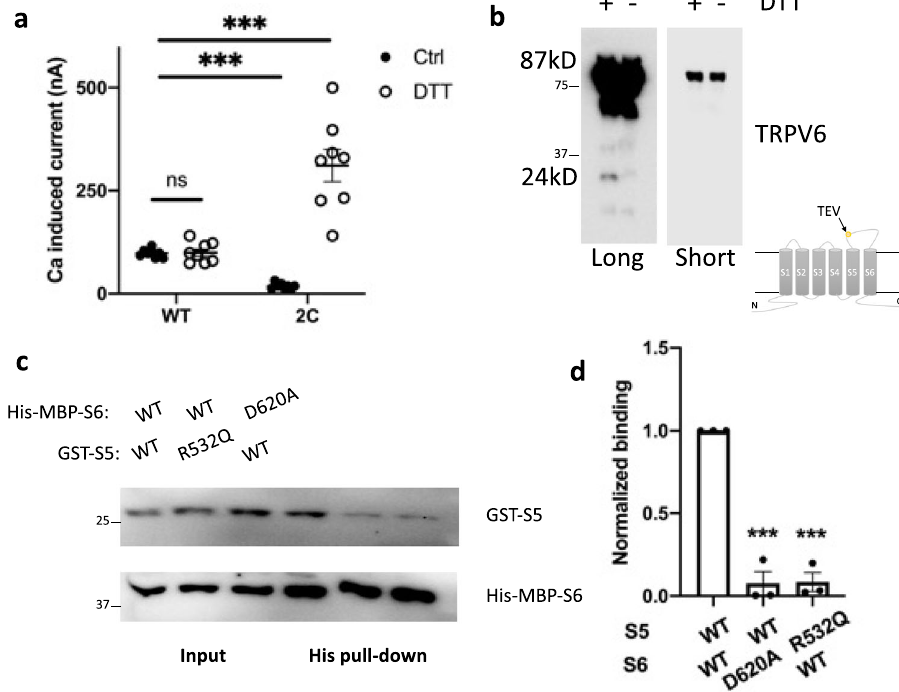
Fig. 2 Associations between R532 and D620 in TRPV6. a Statistical analysis of currents from oocytes expressing TRPV6 or mutant R532C/D620C, with or without 5 μ M DTT. *** p < 0.001; ns not signi fi cant. b Representative WB images with long (long) or short (short) exposure time showing the DTT effect on mutant R532C/D620C TEV . illustration indicating the insertion site of the TEV cleavage. c Representative images on interaction between puri fi ed S5 and S6 fragments, without or with an indicated mutation. d Averaged and normalized S5/S6 helix binding, quanti fi ed using ImageJ. *** p < 0.001, from three independent